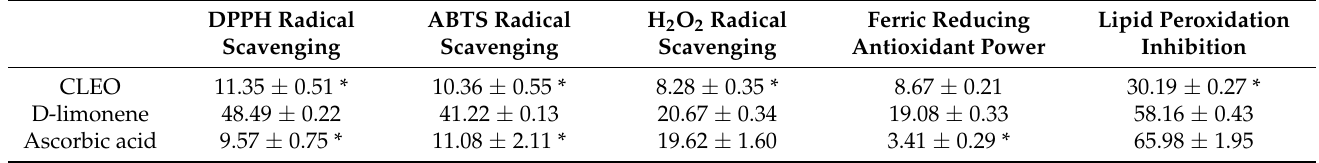
Table 2. Radical quenching abilities of essential oil from Citrus limetta essential oil (CLEO) are expressed in terms of IC 50 ( µ g/mL).